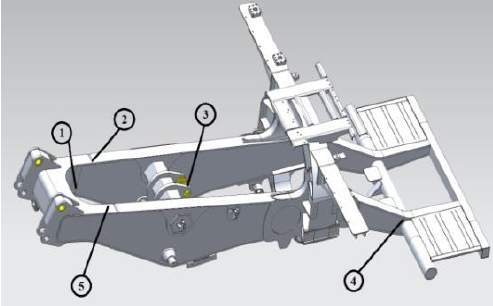
Figure 2. Diagram of the five measurement points.